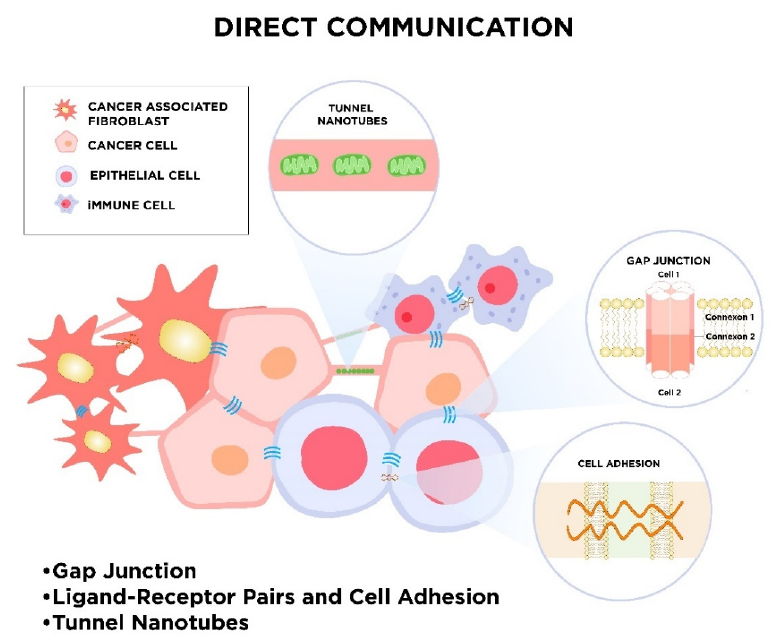
Figure 1. The schematic visualization of direct communication in the tumor microenvironment. The sharing of information between cancer and stromal cells, such as non-cancerous epithelial cells, cancer-associated fibroblasts, immune cells, and others, can occur in different ways, e.g., via gap junction, open-ended cytoplasmic channels (tunnel nanotubes), or through direct ligand–receptor signaling and cell adhesion [18]. These dynamic interplays effectively enable the exchange of cellular cargos over short or long (tunnel nanotubes) distances. For instance, via tunnel nanotubes, mitochondria can be donated from one cell to another in two directions. Gap junctions joint the same and different types of cells and consist of connexions that include six connexins. They are able to transfer rather small molecules and metabolites [19]. Similarly, physical cell–cell attachments via adhesion proteins are impermeable for macromolecules.